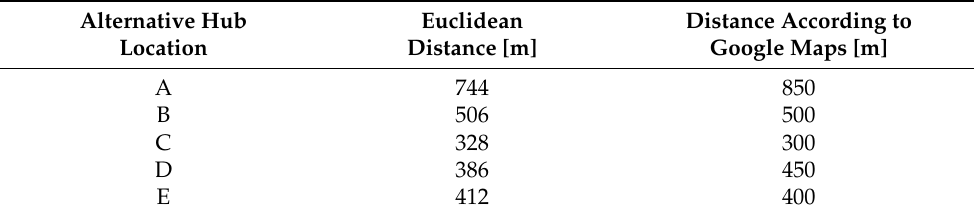
Table 3. Distances from the gravity center to alternative hub